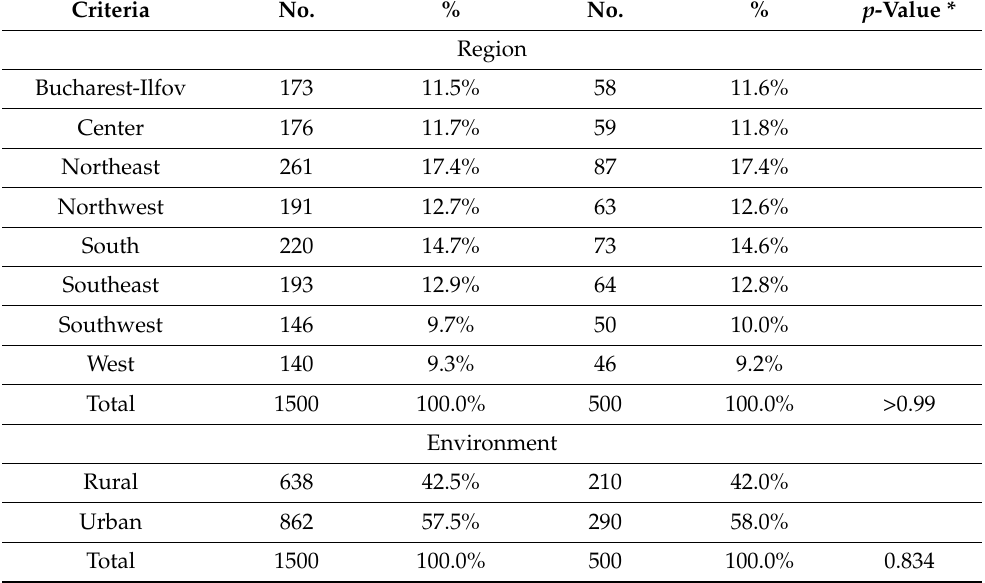
Table 1. Comparative analysis of the groups according to the main demographic variables in stage 2 of the